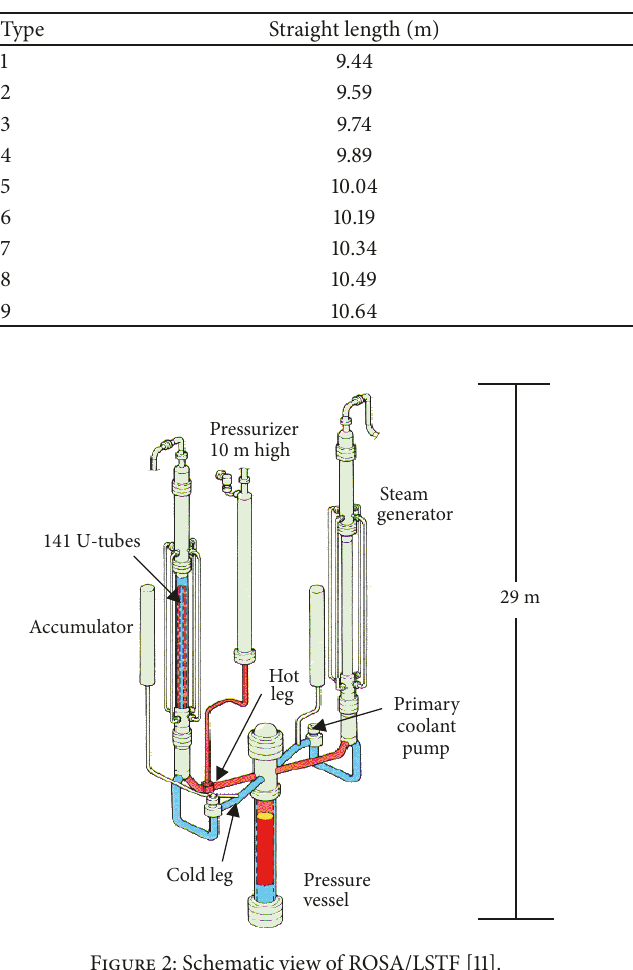
Figure 2: Schematic view of ROSA/LSTF